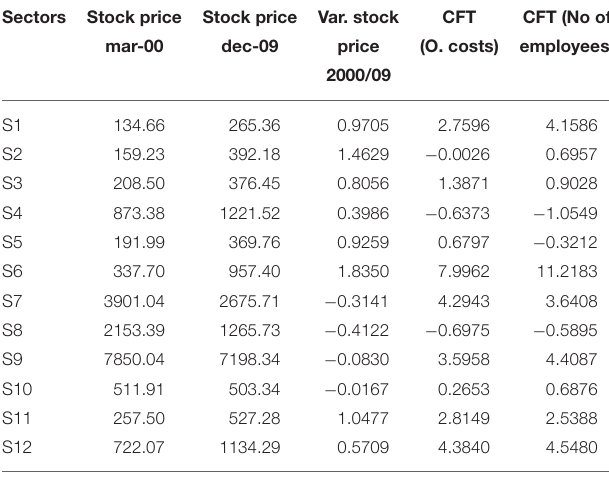
TABLE 6 | Relationship between stock price variation and FT coefficients at the sector